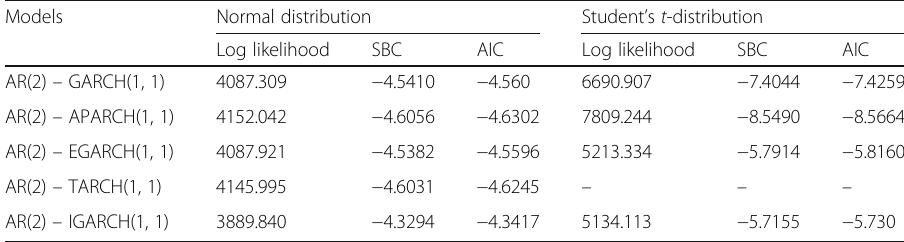
Table 7 Comparison of models in within sample estimation accuracy